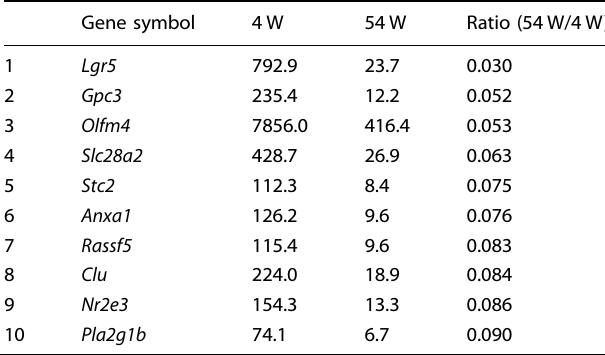
Table 1. Genes differentially expressed between intestinal epithelial organoids derived from mice aged 4 and 54